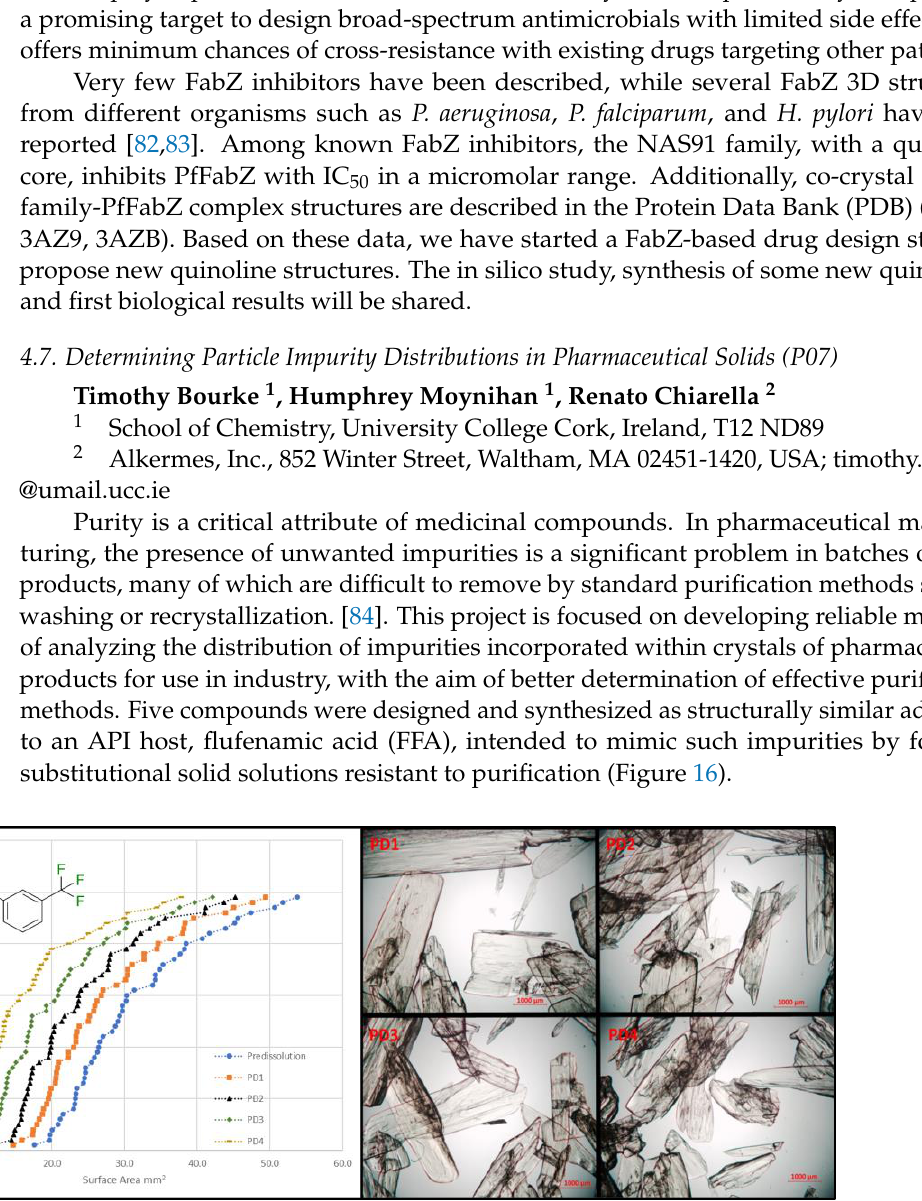
Figure 16. Size distributions ( left ) and microscope images ( right ) over a series of stepwise dissolutions.